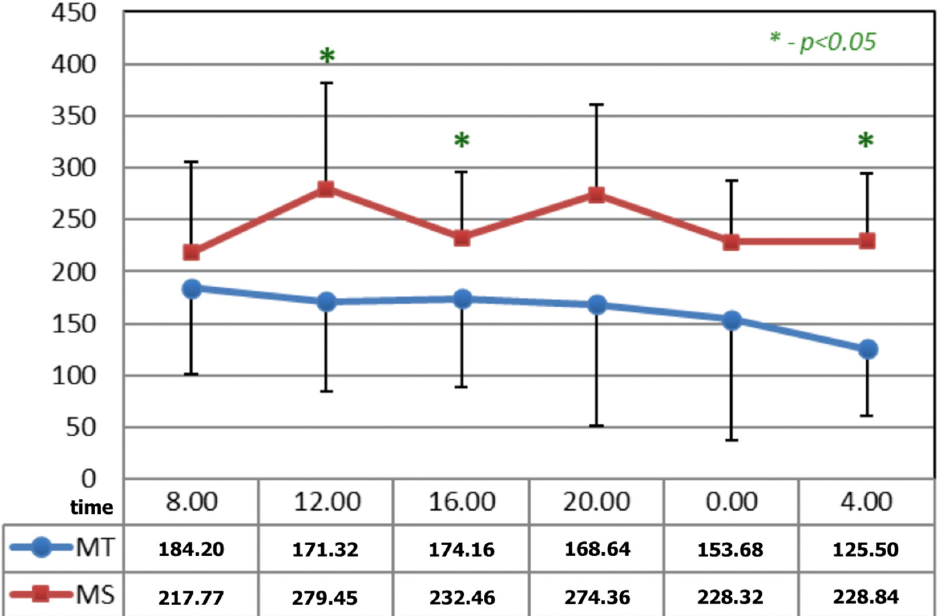
Figure 3. Comparison of the circadian concentration (ng/mL) of serotonin before the applications of magnetic fields—magnetotherapy and magnetic stimulation. * statistical significance.